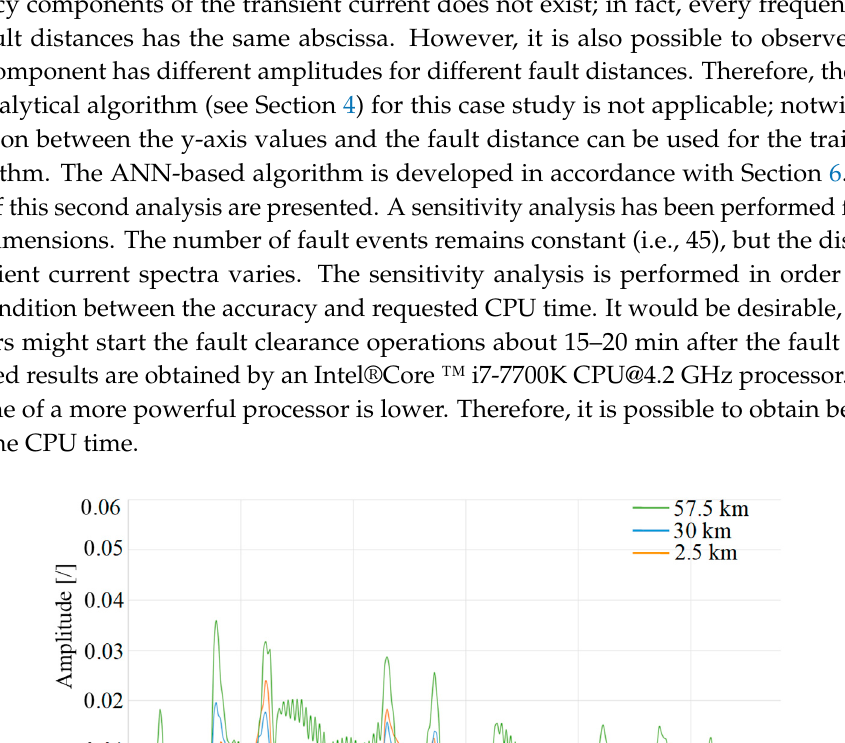
Figure 10. Charge and discharge transient circuits for a double-circuit OHL during a PtG fault (subscript 1 and 2 in the p.u.l. phase inductances refer to OHL 1 and OHL 2 and not to positive and negative sequence).